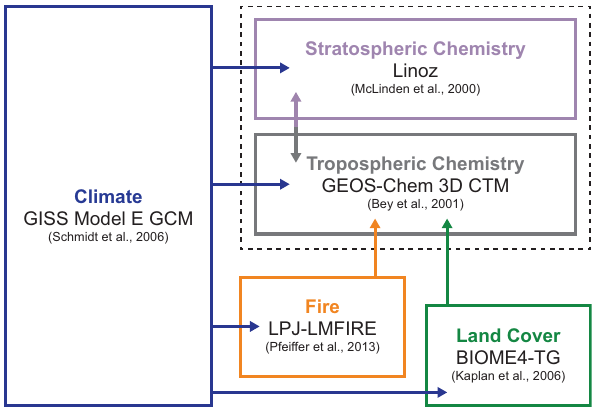
Figure 1. The ICE age Chemistry And Proxies (ICECAP) model framework consists of four global models, represented here by boxes with solid lines. The stratospheric and tropospheric chemistry schemes are coupled online in the GEOS-Chem chemical transport model (CTM). Arrows indicate the flow of model output. The ICE- CAP model framework was especially designed for simulating the oxidative capacity of past atmospheres. (Adapted from Murray et al., 2014, Fig.